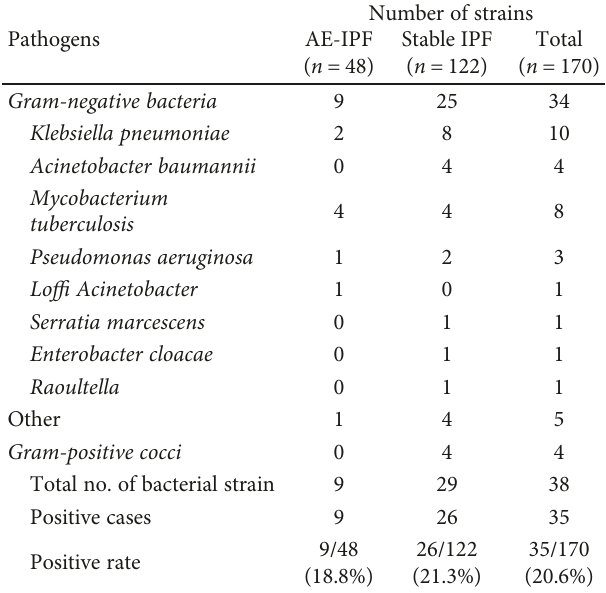
Figure 2: Kaplan-Meier survival analysis showing signi fi cantly higher mortality of AE-IPF than IPF (stable IPF) by using the log-rank test ( p = 0 039 ). AE-IPF patients (39.5%) had higher one-year mortality than stable IPF (28.7%) ( p = 0 041 ). In AE-IPF